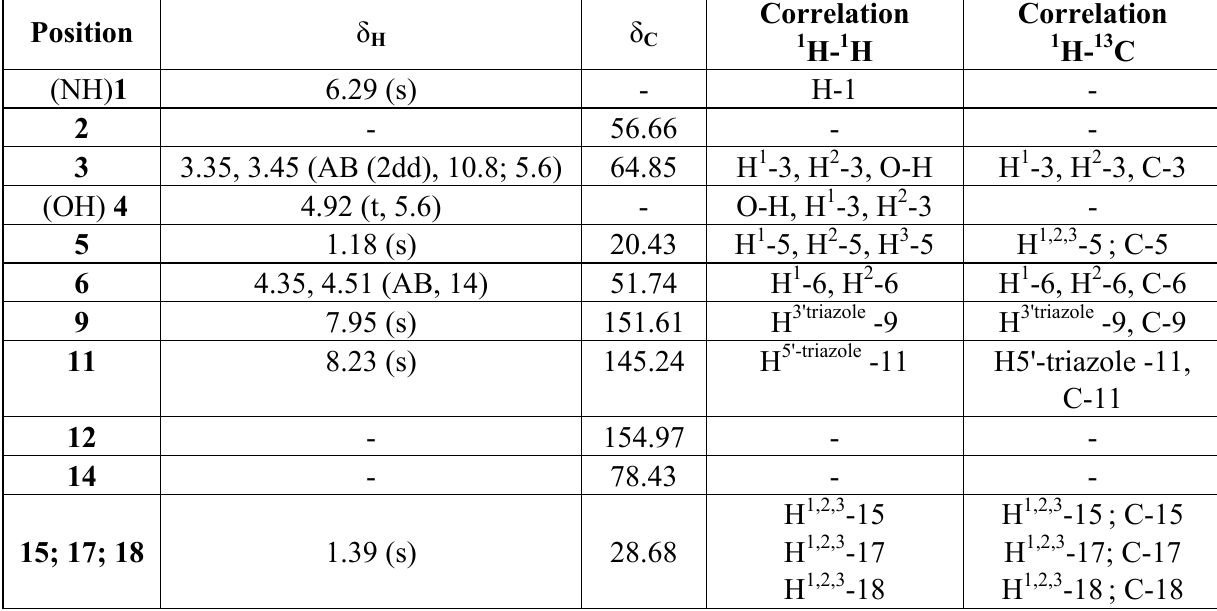
Table 1. 1 H (300 MHz) and 13 C (75.47 MHz) NMR spectral data for compound 4 in DMSO- d6 , including results obtained by homonuclear 2D shift-correlated and ) a . Chemical shifts ( δ , ppm) and heteronuclear 2D shift-correlated HMQC ( 1 J CH